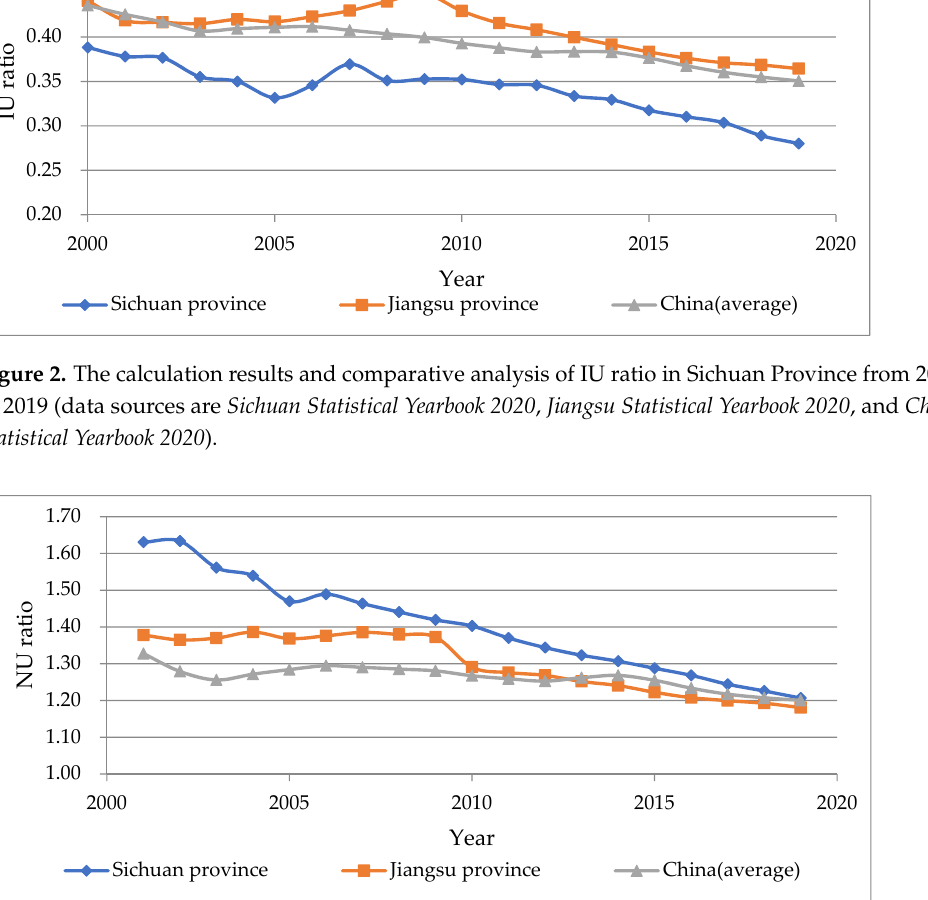
Figure 3. The calculation results and comparative analysis of NU ratio in Sichuan Province from 2001 to 2019 (data sources are Sichuan Statistical Yearbook 2020 , Jiangsu Statistical Yearbook 2020 , and China Statistical Yearbook 2020 ).